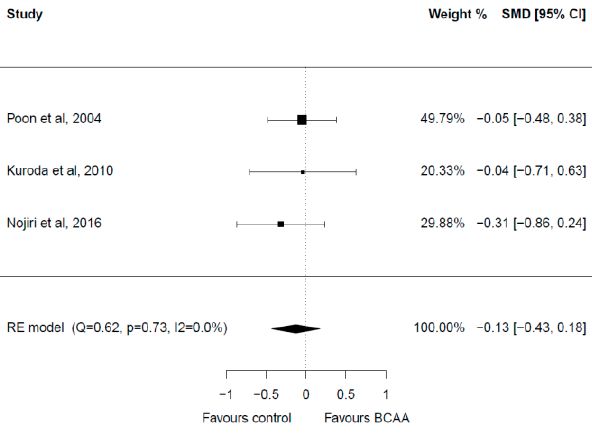
Figure 6. Forest plot for AST [28,32,33].